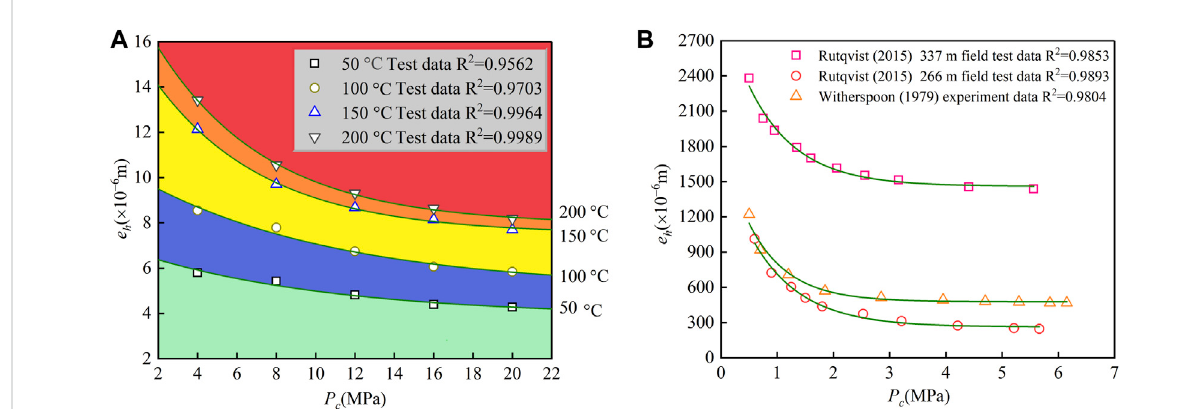
FIGURE 6 Evaluation of the proposed model for the relationship between the hydraulic aperture and the con fi ning pressure based on Sun ’ s model of the fracture deformation constitutive law. (A) Hydraulic aperture and con fi ning pressure test data for various temperatures. The green area represents the part where the temperature is less than 50 ° C, the blue area represents the part where the temperature is greater than 50 ° C and less than 100 ° C, and the yellow area represents the part where the temperature is greater than 100 ° C and less than 150 ° C, the orange area represents the part where the temperature is greater than 150 ° C and less than 200 ° C, and the orange area represents the part where the temperature is greater than 200 ° C. (B) The fi eld test data for the hydraulic aperture and con fi ning pressure for fractures at depths of 266 and 227 m, and the test data from an ultra-large core experiment. The solid line is the fi tting curve for the Sun model, and the discrete symbols are the test